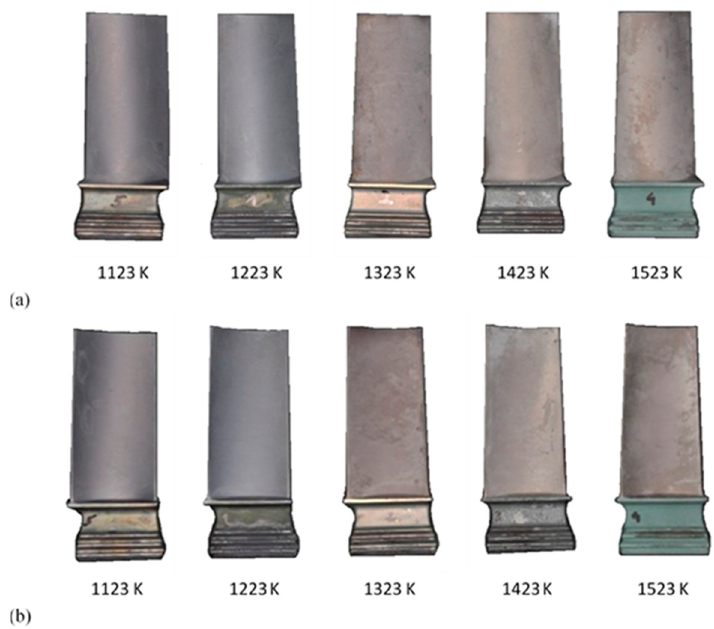
Figure 7. General view of blade surfaces after heating in the presence of aviation kerosene exhaust gases: ( a ) convex surfaces; ( b ) concave surfaces. (Reprinted with permission from Ref. [2]. 2012, AFIT.).